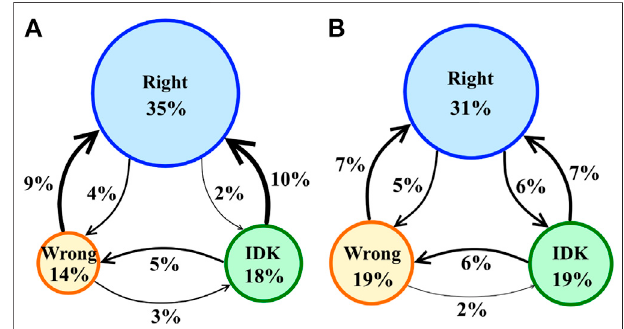
FIGURE 3 | Learning fl ow diagrams for T ū hura visitors who interacted (A) with the exhibits ( n (cid:1) 409, n ’ (cid:1) 1913) and those who did not interact (B) with the exhibits (right, n (cid:1) 26, n ’ (cid:1) 127). n stands for the number of respondents, n ’ for total number of responses. Answers to the scienti fi c content knowledge test were recoded as Right, Wrong and I Don ’ t Know (IDK). All of the items (except the control question) were pooled together 20 . Responses were split into groups of visitors who interacted with the exhibits and visitors who did